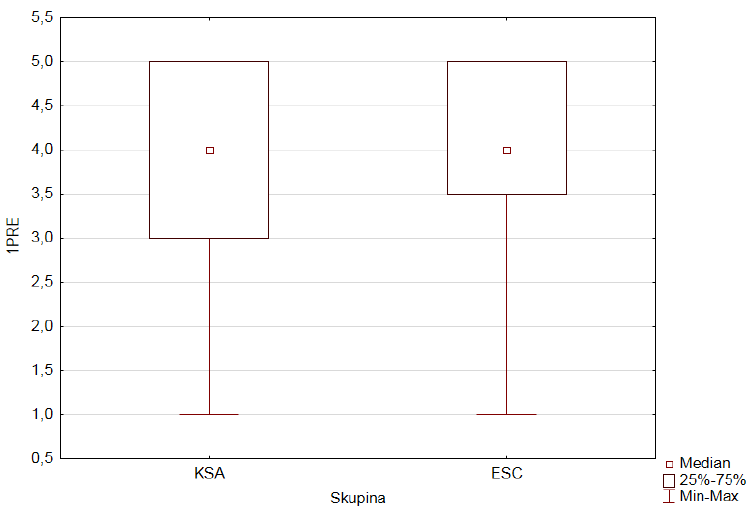
Figure 3. Box graphs of the first item of the pretest - 1PRE.